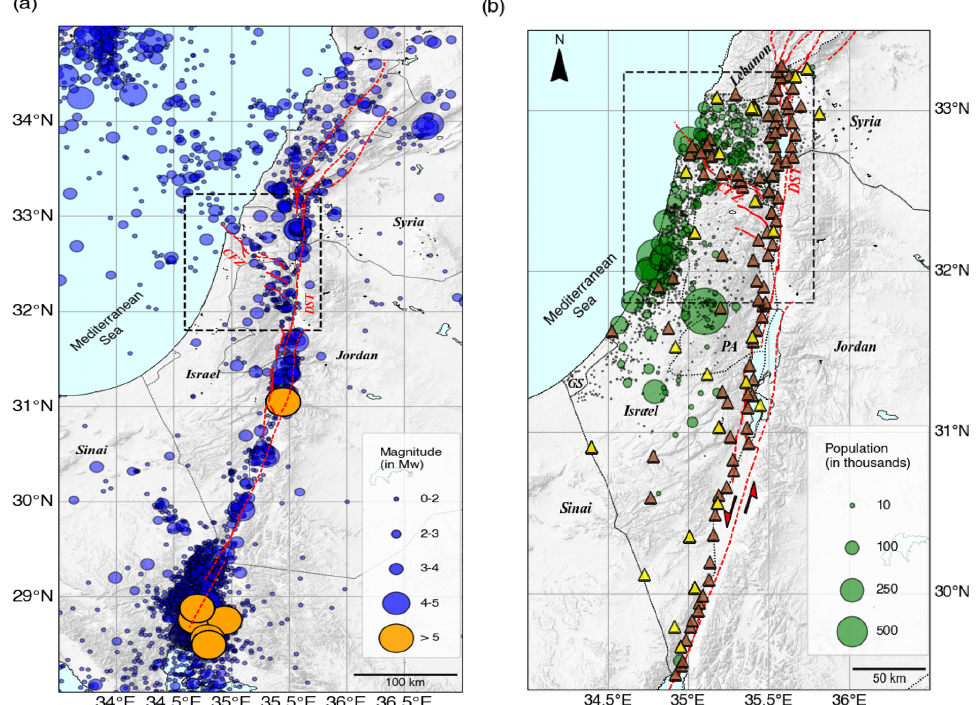
Figure 1. (a) Israel seismic catalog ( M w ) for the period 1985–2021. Orange circles are events with M w > 5 (expansion of Wetzler and Kurzon, 2016a, catalog). Red lines are active tectonic borders and faults, DST is Dead Sea Transform, and CFZ is Carmel Fault Zone. (b) Demographics of Israel and the Palestinian Authority (PA) and the deployment of the Israel Seismic Network. Yellow triangles are the old (up to October 2017) Israel Seismic Network stations, and brown triangles are the current (TRUAA) seismic network stations (after Kurzon et al., 2020a). GS is Gaza Strip. The black rectangles define the computational domain presented in Fig. 3a.